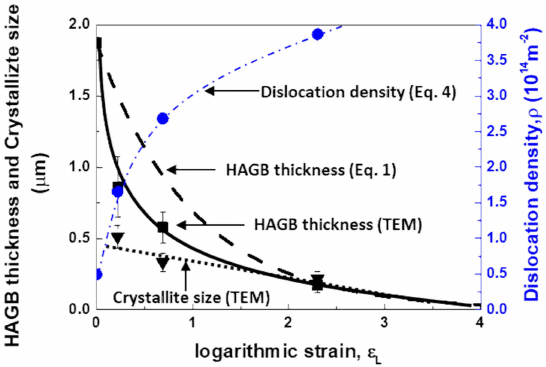
Figure 10. Evolution of the HAGB thickness, crystallite size, and dislocation density with increasing the logarithmic strain in the AA3003 aluminum